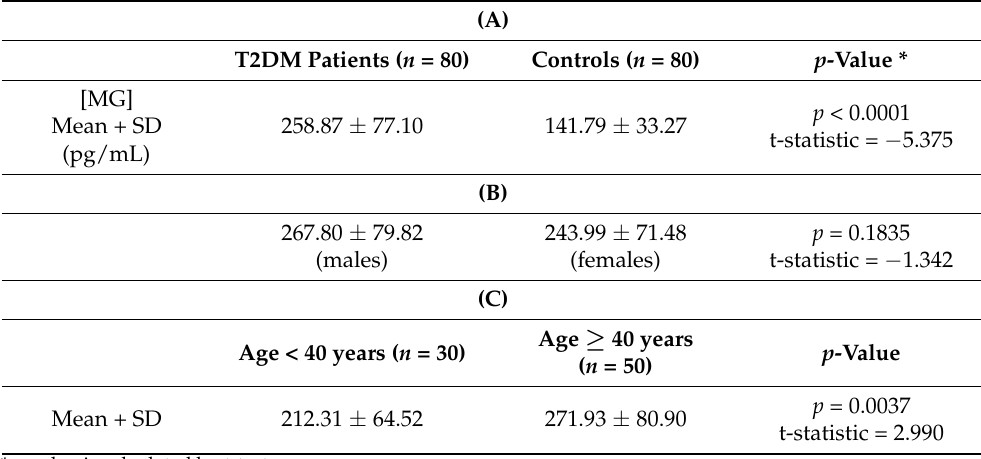
Table 10. ( A ) Serum methylglyoxal in T2DM patients and controls. ( B ) Serum methylglyoxal in male and female patients. ( C ) Serum methylglyoxal in different age groups in